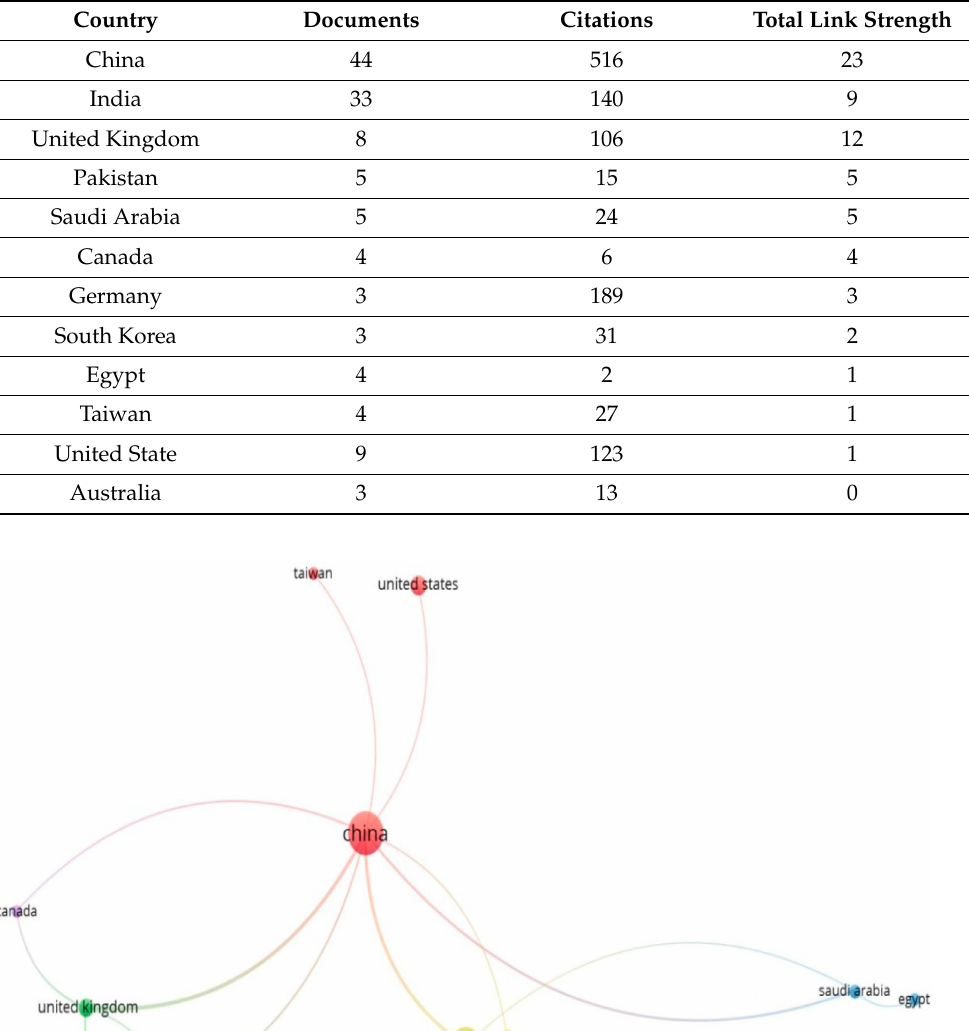
Table 4. Structure of Connections in the literature Country Wise.